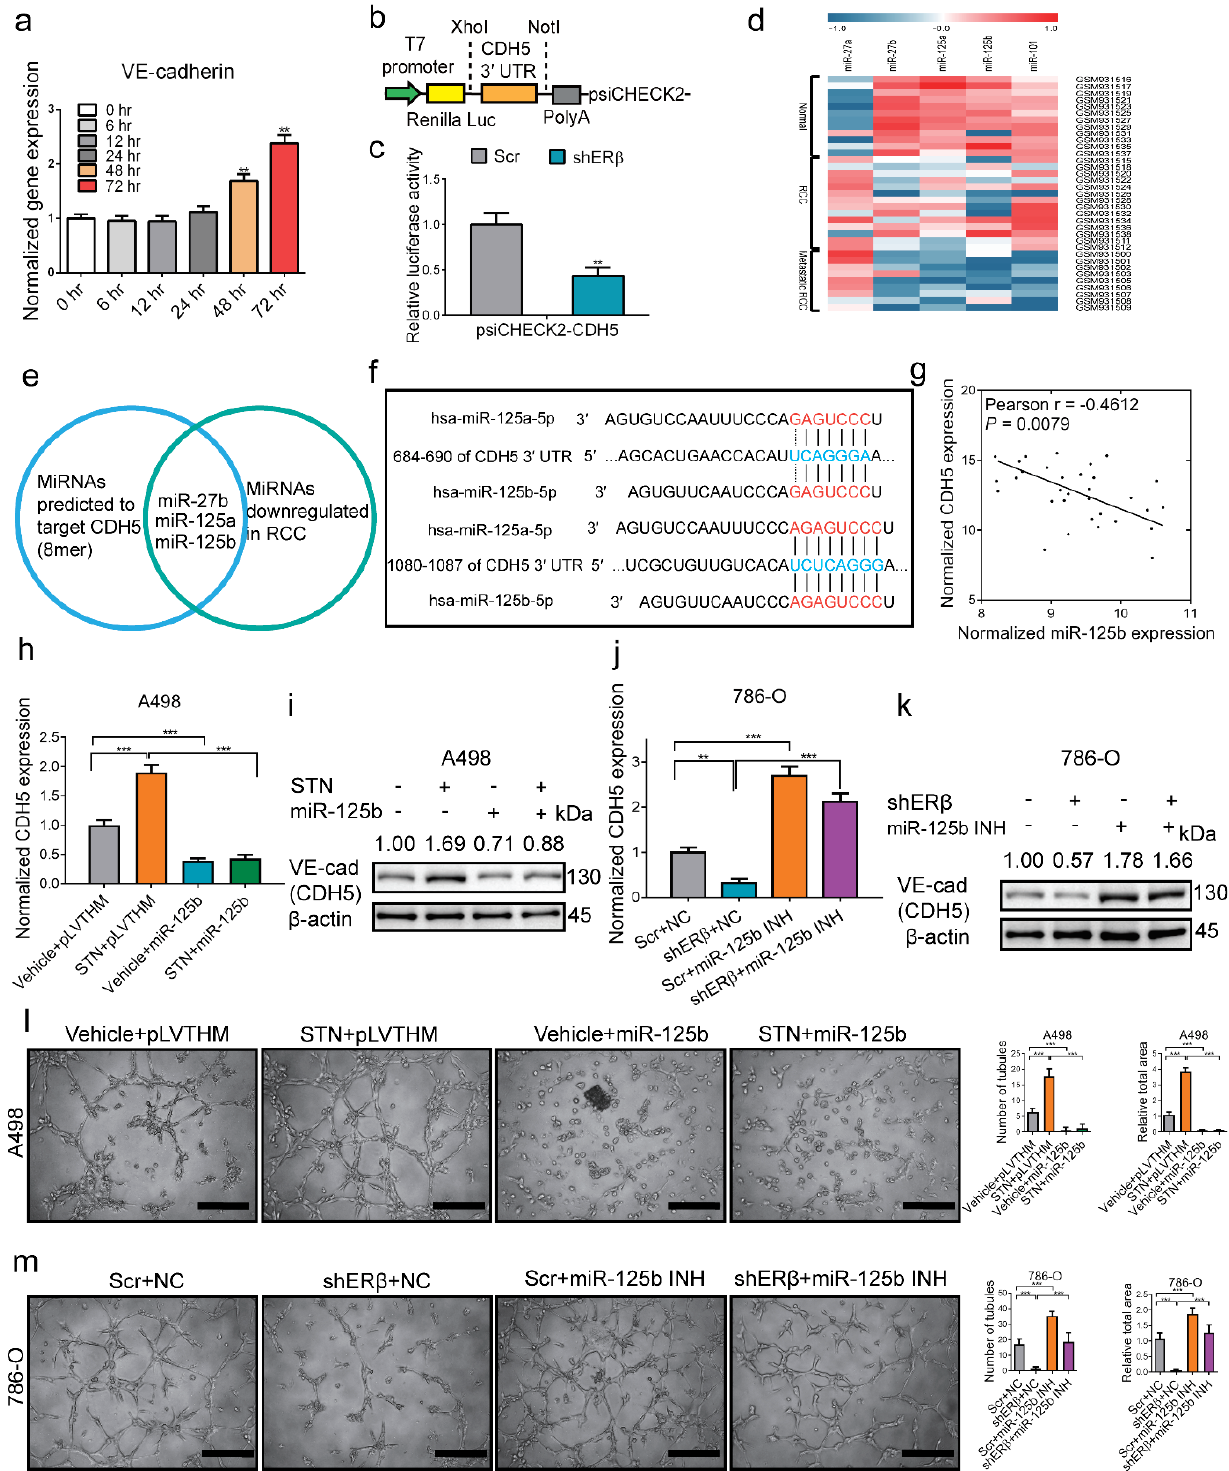
Figure 2. The miRNA-125-5p targets the 3 ′ UTR of VE-cadherin and is involved in mediating ER β ’s effect on VE-cadherin. ( a ) The qPCR detection of VE-cadherin mRNA at different time points after 10 nM E2 treatment. ( b ) Diagram of constructing the 3 ′ UTR of VE-cadherin (CDH5) using psiCHECK2 vector. ( c ) Knocking down ER β (shER β ) decreased psiCHECK2-CDH5 luciferase activ- ity. ( d ) The miRNA heatmap of clinical RCC samples (GSE37989) for screening key miRNAs target- ing VE-cadherin (CDH5). Red stands for higher expression and blue stands for lower expression. ( e ) Algorithm for selecting potential tumor suppressor miRNA targeting VE-cadherin. ( f ) Binding